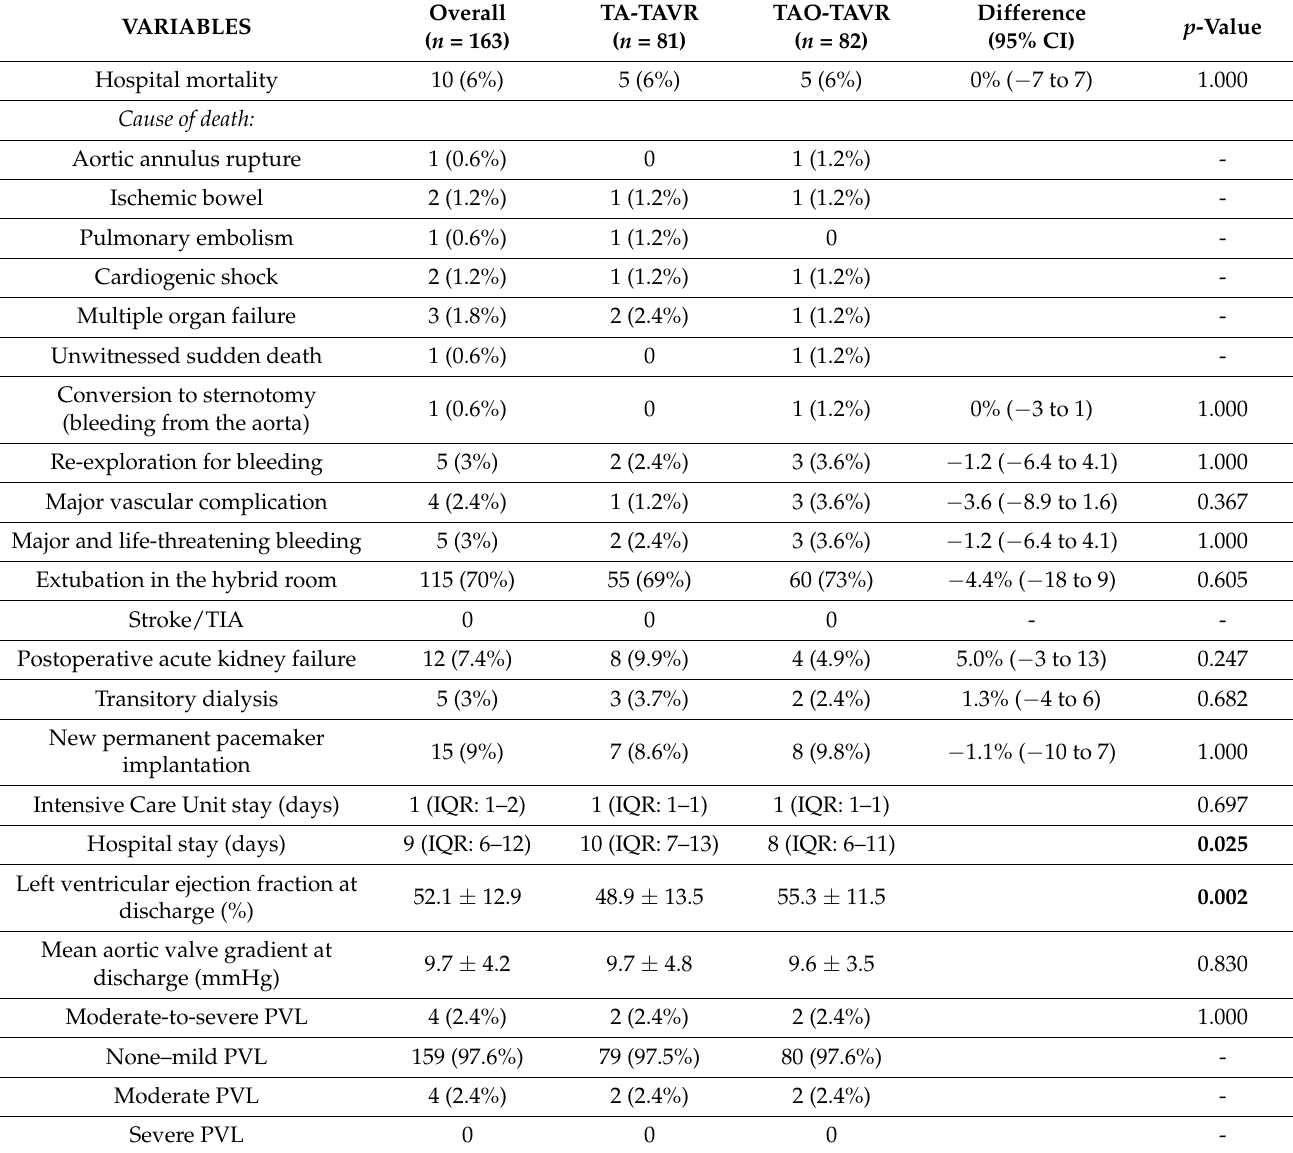
Table 4. Outcome at 30